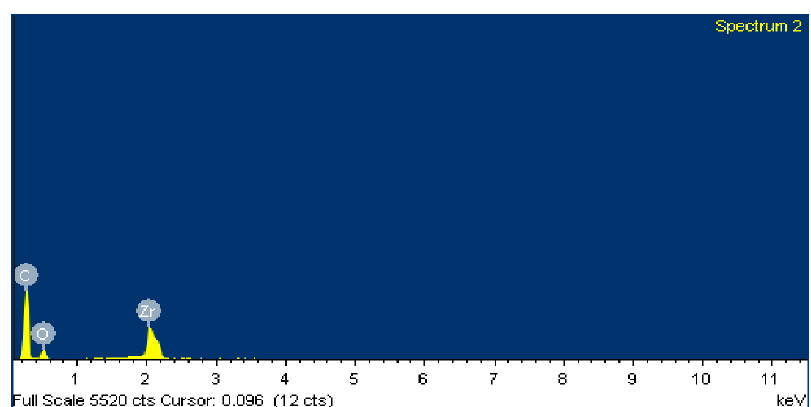
Figure 18. EDS spectrum for zone 2 in a local area marked with an arrow in Figure 16, where ZrO 2 is located.